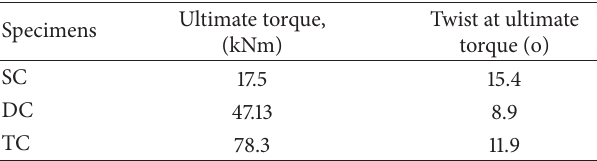
Table 3: Ultimate torque and corresponding twist angle of speci-